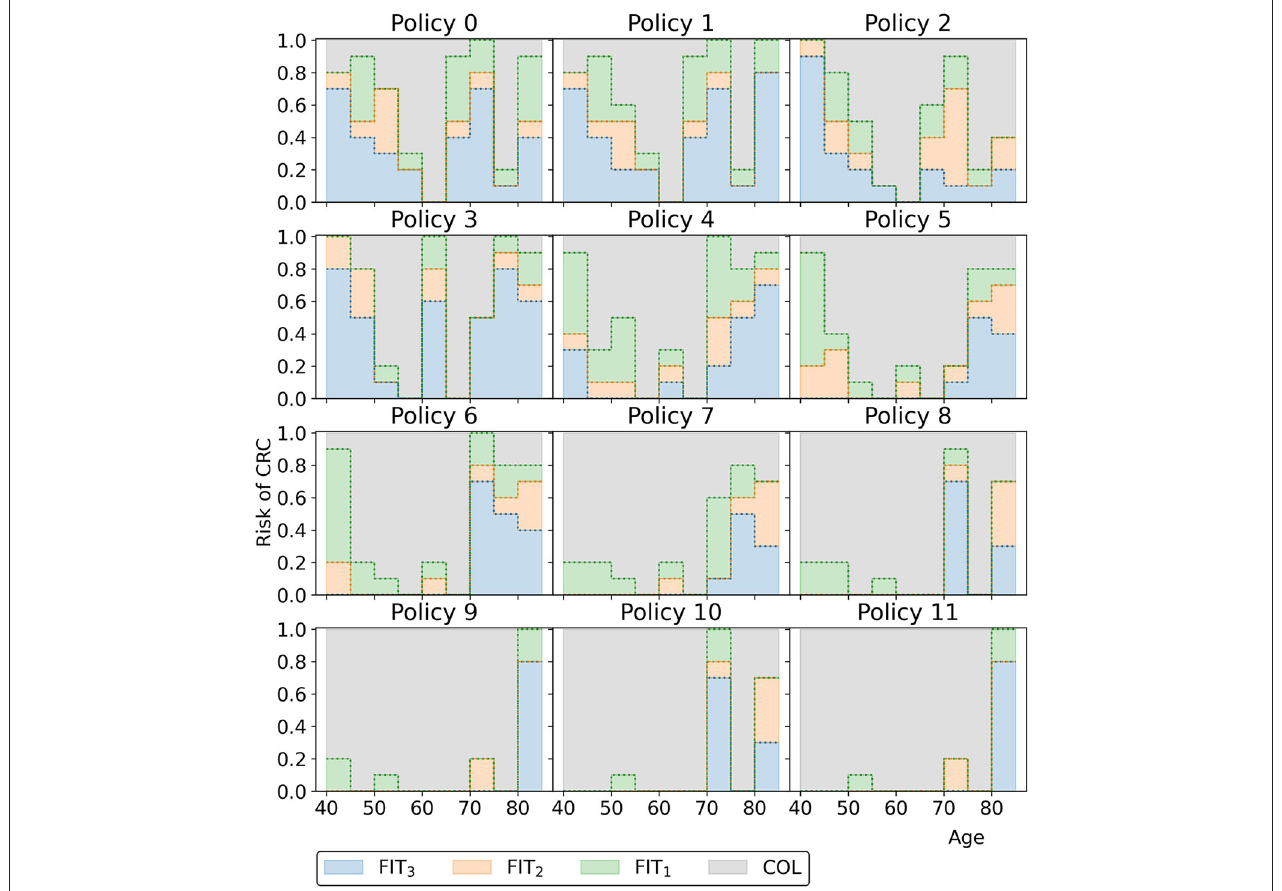
FIGURE 12 | The policies that form the minimal representation of the approximation set of Experiment 2 as shown in Figure 10 .